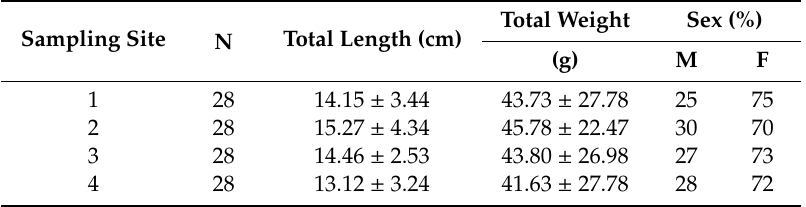
Table 1. Sampling site, total length (mean ± SD), total weight (mean ± SD), and sex (male—M or female—F) of fish (N) sampled in